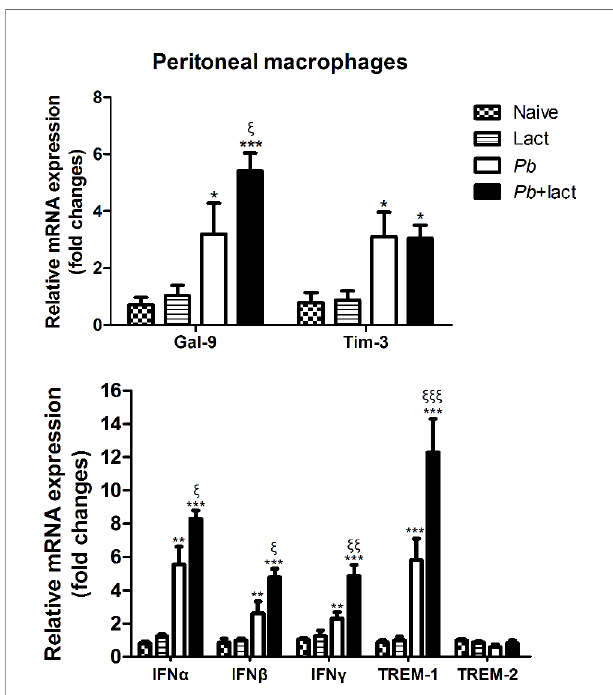
FIGURE 8 | Relative mRNA expressions of Gal-9, Tim-3, IFN a , IFN b , IFN g , TREM-1, and TREM-2 expressions in murine peritoneal macrophages were examined ex vivo from Pb ANKA-infected mice with or without a -lactose treatment on day 7 p.i. by using qRT-PCR. Values are means from triplicate measurements, and data are presented as means ± SD; two independent experiments were performed. * P < 0.05, ** P < 0.01, and *** P < 0.001, a -lactose-control, malarial mice on day 7 p.i., and malarial mice with a -lactose treatment on day 7 p.i. vs . naive group; x P < 0.05, xx P < 0.01, and xxx P < 0.001, malarial mice with a -lactose treatment on day 7 p.i. vs . malarial mice on day 7